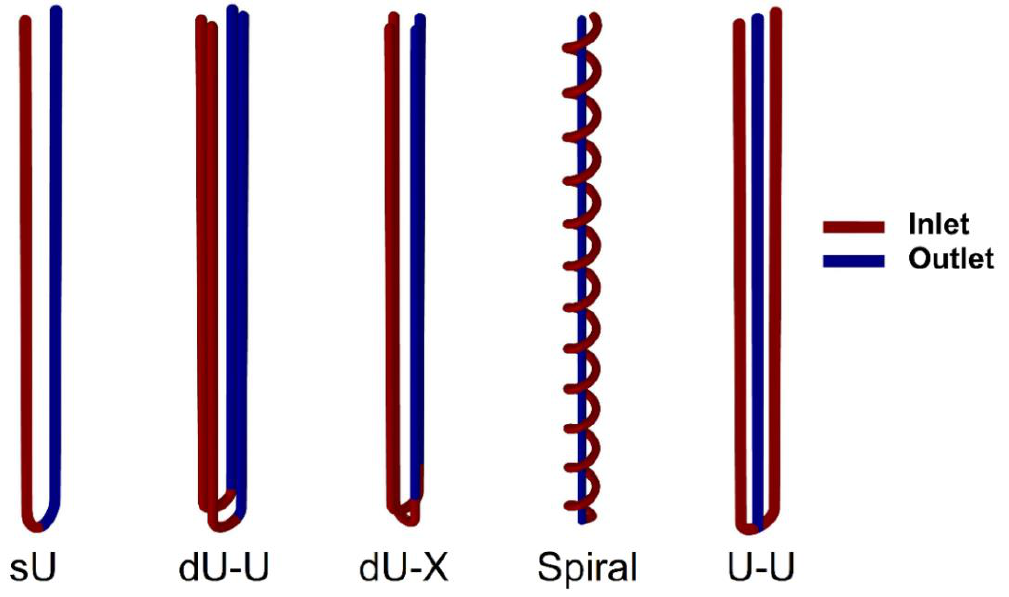
Figure 12. Geometric configurations of BHE.